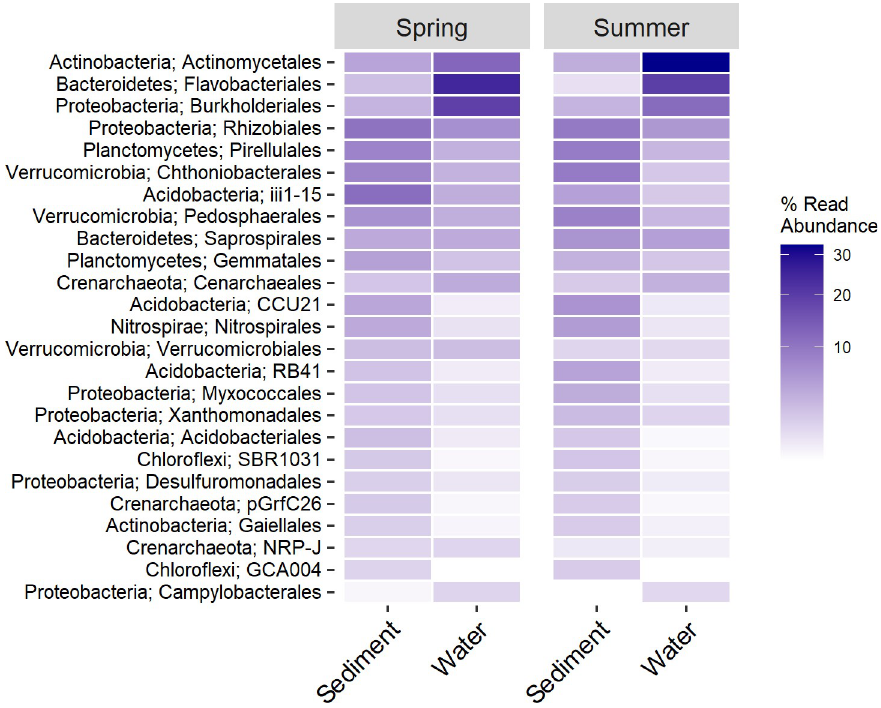
Fig 4. Abundances of orders important to predicting stream condition from sediment samples. Taxa are arranged top to bottom by their overall abundances within the entire dataset including water sample.